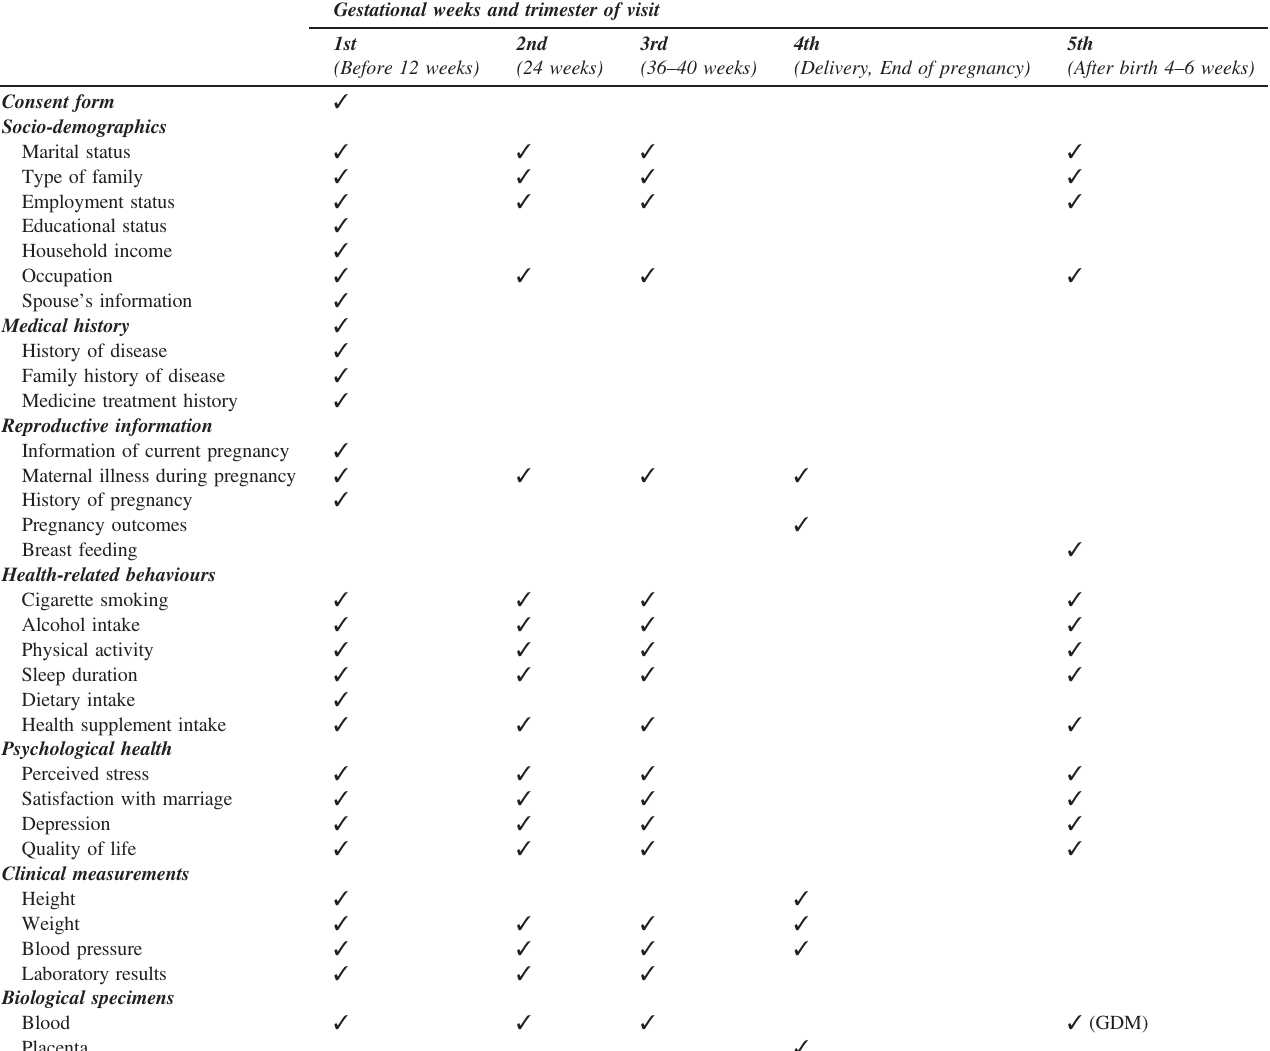
Table 1. Outline of measures for pregnant women in KPOS research Gestational weeks and trimester of